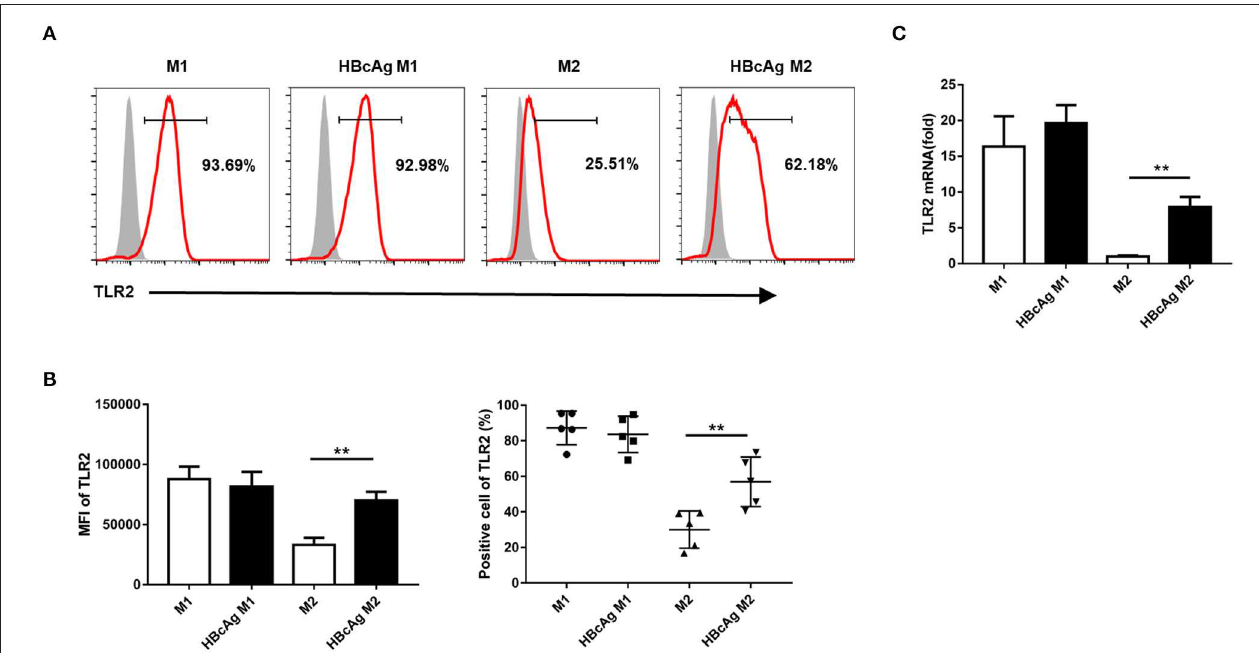
FIGURE 4 | TLR2 expression in M2 macrophages was upregulated via HBcAg stimulation. (A–C) 10 µ g/ml HBcAg or an equal volume of PBS was added simultaneously with LPS/IFN- γ or IL-4 to unpolarized M1 or M2 M Φ and incubated for an additional 24h for further polarization. (A) Representative flow cytometric graphs and (B) cumulative results calculating MFI and positive cells showing TLR2 expression in M1 and M2 M Φ stimulated with either PBS or HBcAg. (C) TLR2 mRNA level in M1 and M2 M Φ stimulated with either PBS or HBcAg was analyzed by RT-qPCR. Experiments in (A–C) were repeated at least two times. Data were analyzed using a paired Student’s t -test. Results are shown as the mean ± SEM ( A,B , n = 5; C , n = 3). ** p < 0.01.